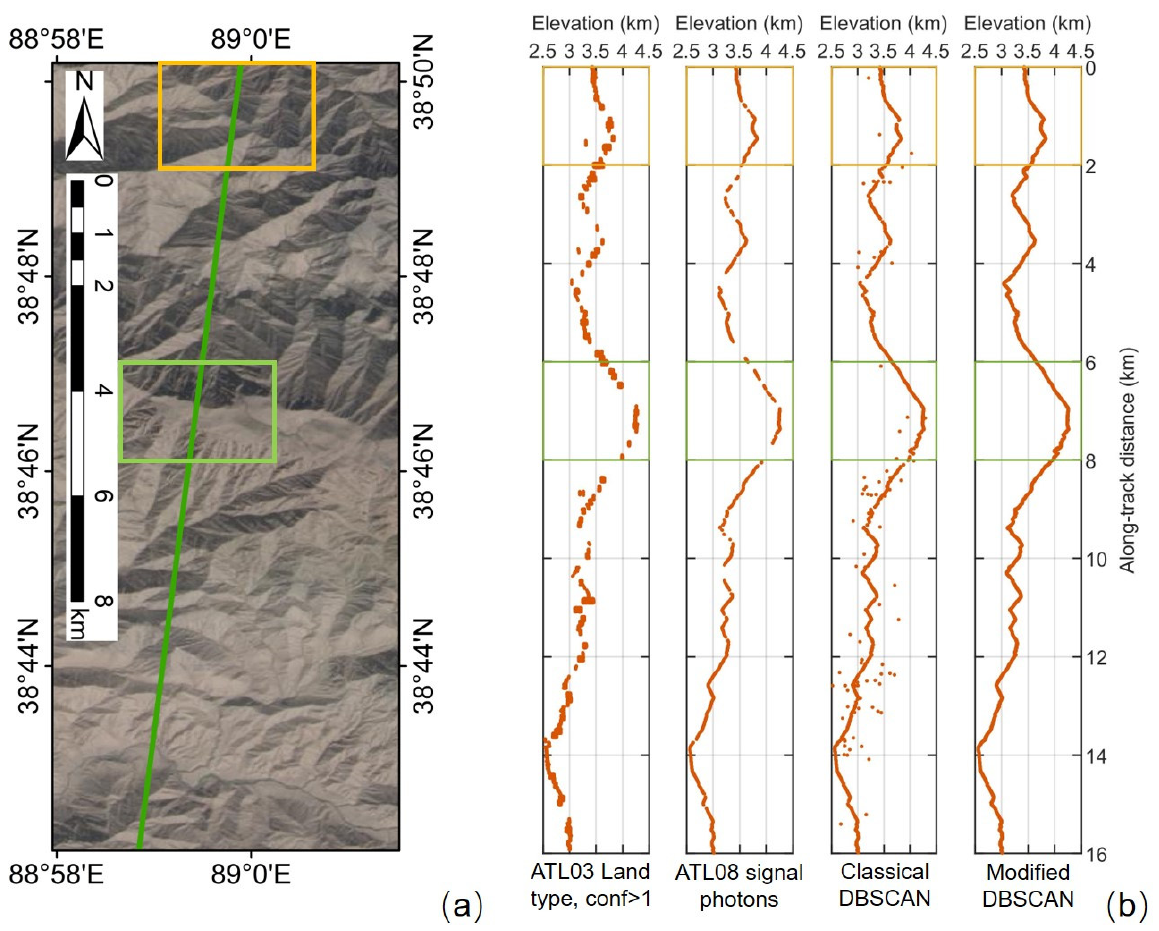
Figure A1. ( a ) ICESat-2 ATLAS ground track (from north to south or a descending track) and satellite imagery in the Altun Mountains. The Altun Mountains are located between the Taklimakan Desert and the Gurbantunggut Desert, which makes this area very dry. The surface is covered by bare-land and very sparse grasslands. ( b ) The signal photons extracted by different methods. The diameter and threshold of the classical DBSCAN were set as 4 m and 4, respectively. Two sampled segments within the yellow and green boxes were enlarged and illustrated in Figure A2a,b, respectively.